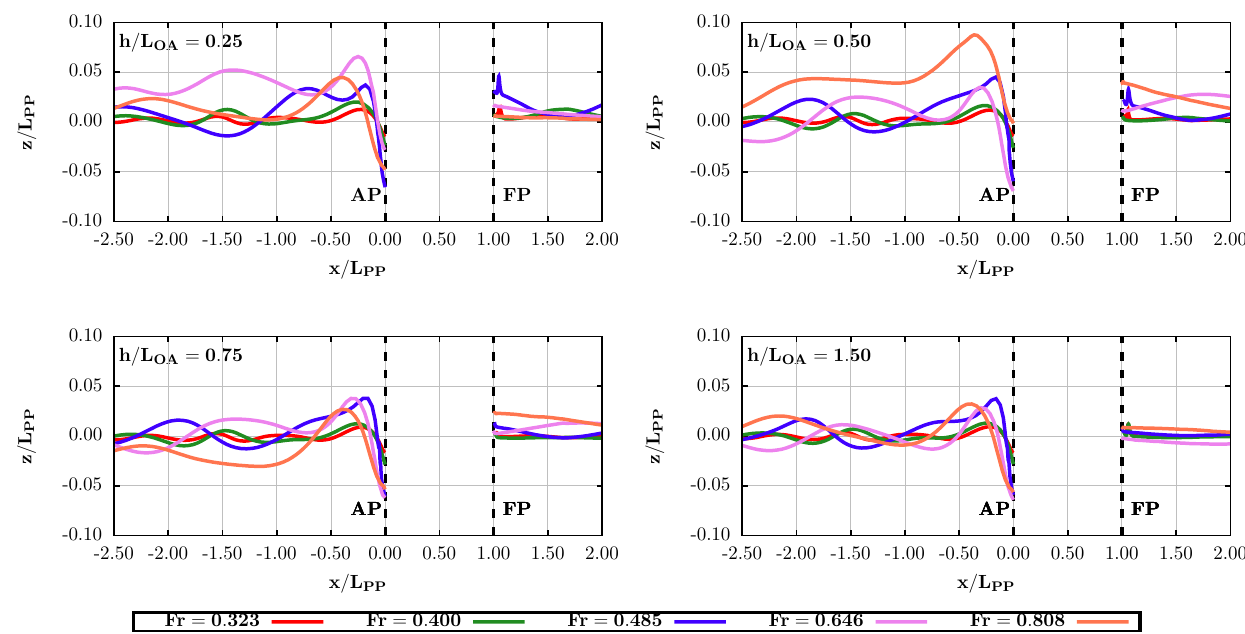
Figure 14. Longitudinal wave cuts at the mid-plane of the pontoon at different water